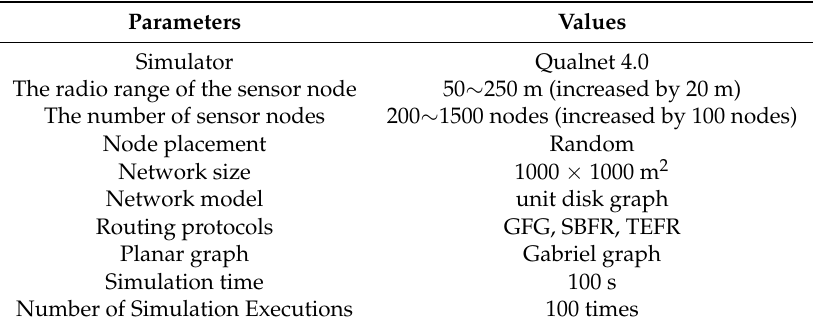
Figure 11. Transfer time according to radio range (deployed nodes: 500). Table 4. Simluation